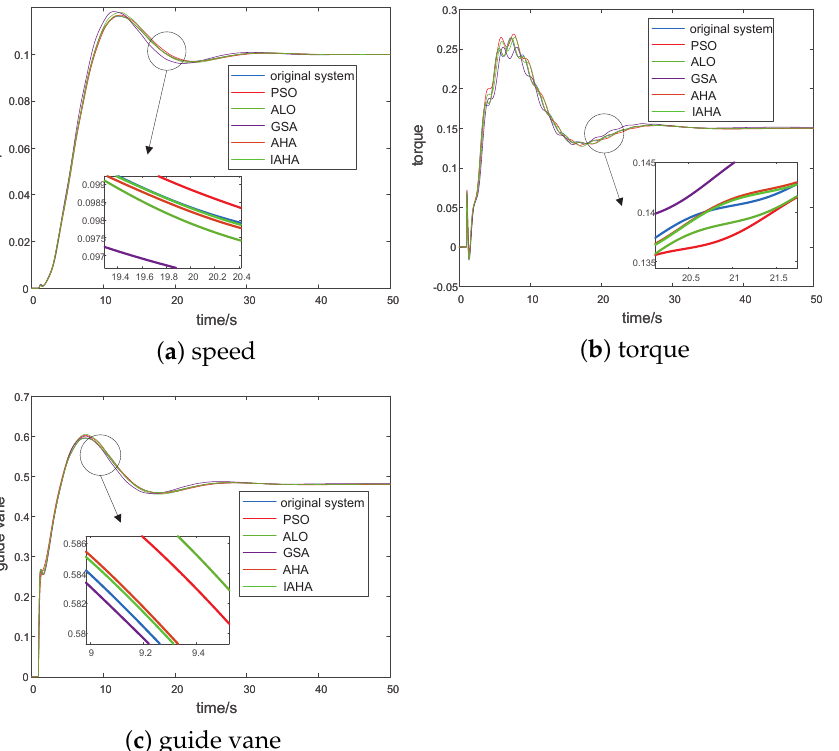
Figure 14. Comparison of the output between different optimization algorithms for 10% frequency disturbance